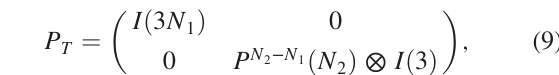
FIG. 3. The tunes extracted from second-order moment one-turn matrix M T (top) and the largest modulus of its eigenvalues (bottom) as a function of the beam-beam parameter. In this example, the number of bunches in two rings are ð N 1 ; N 2 Þ ¼ ð 3 ; 4 Þ . The tunes are ð ν 1 ; ν 2 Þ ¼ ð 0 . 22 ; 0 . 4 Þ